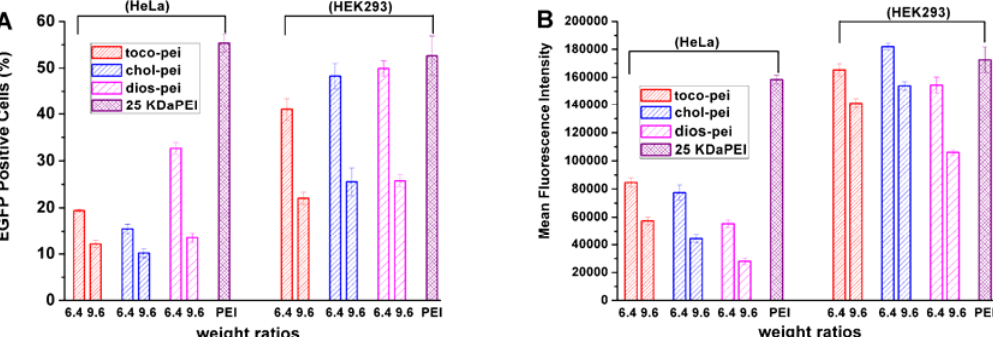
Figure 9. Transfection efficiencies of lipopolymer/DNA polyplexes at different weight ratios ( w / w = 6.4 or 9.6) toward HeLa and HEK293 cells with a serum-free medium; 25-kDa PEI was used for comparison. Data were considered as the percentage of cells expressing ( A ) EGFP-positive cells and ( B ) mean fluorescence intensity (MFI) measured using flow cytometry analysis.